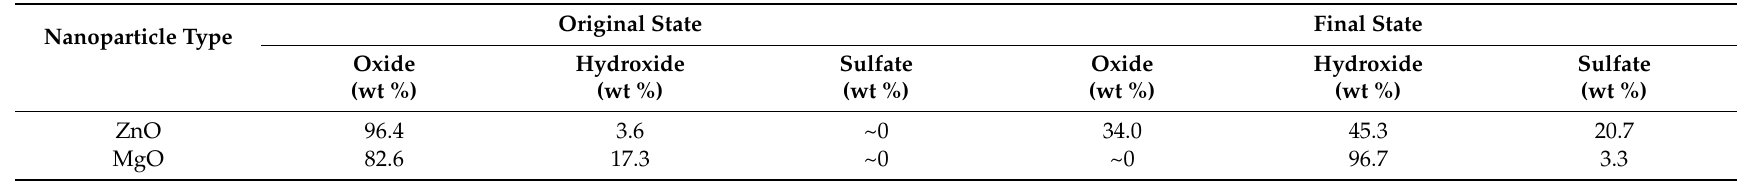
Table 4. Estimation of nanoparticle character before and after being subjected to polymerization conditions. Results were calculated using ICP-OES results and molar masses of presumed